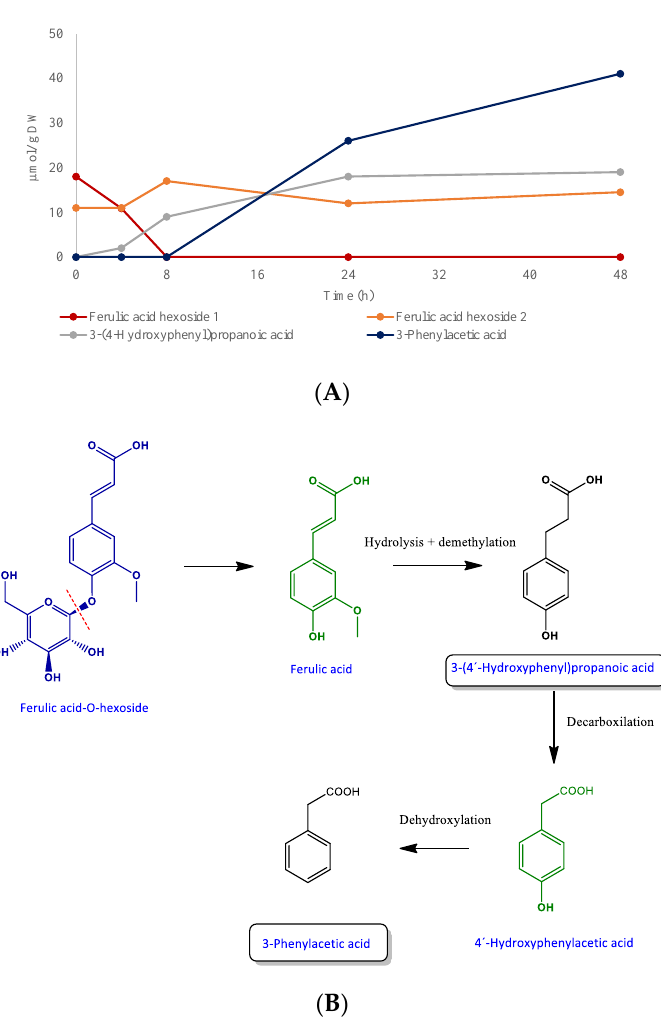
Figure 2. ( A ) Ferulic acid-hexoside degradation profiles over 48 h of incubation with human faeces. Data expressed as µmol ± SD (n = 3). ( B ) Proposed catabolic pathway for the colonic transformation of ferulic acid-hexoside in humans. Black: detected metabolites; green; non-detected metabolites. Framed names indicate major catabolites.